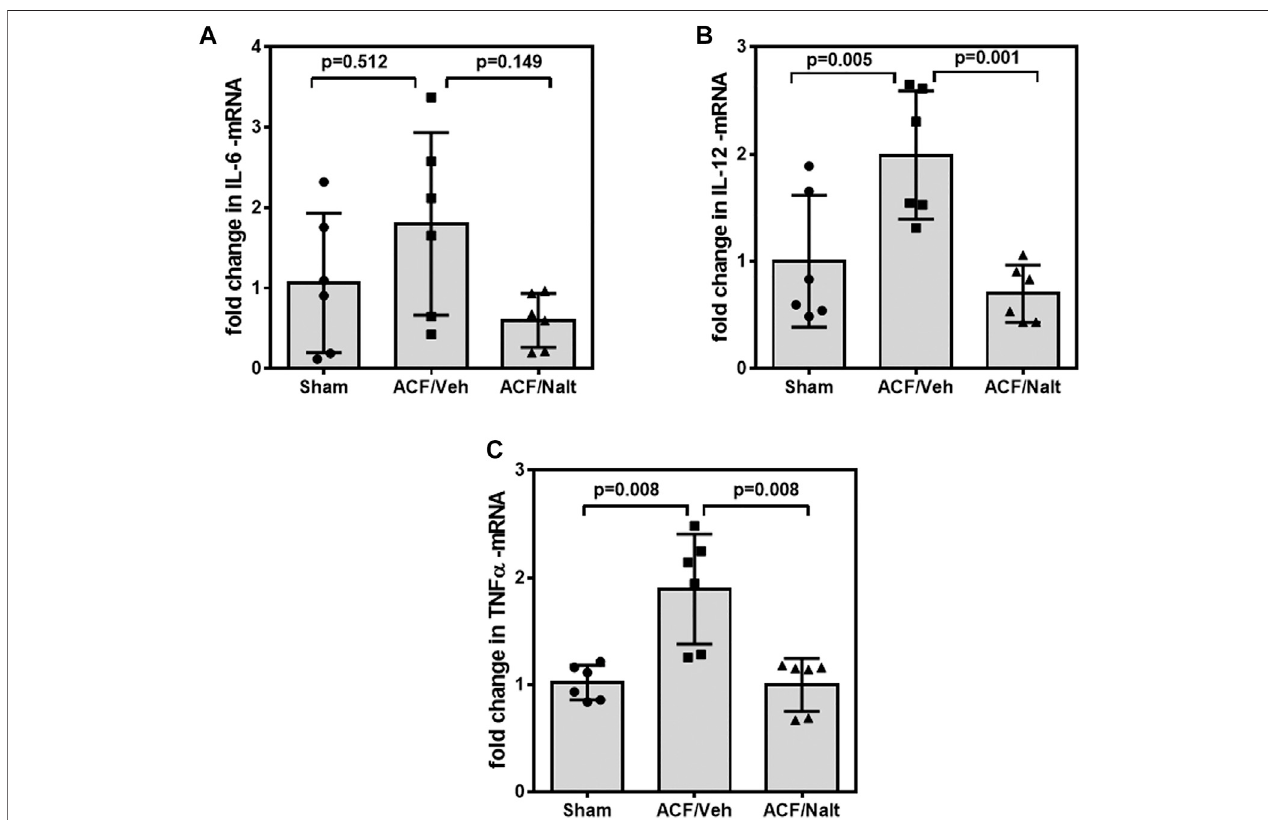
FIGURE6| QuantitativeRT-PCRInterleukin6(IL-6) (A) ,Interleukin12(IL-12) (B) andtumornecrosisfactor α (TNF-alpha) (C) speci fi cmRNAvaluesofcontrol,ACF/ Vehicle- and ACF/Naltrexone-treated rats. Values of in fl ammatory cytokines were signi fi cantly increased in ACF/Vehicle treated rats compared to controls (IL-12: p = 0.005; TNF-alpha: p = 0.008) but not for IL-6 ( p = 0.512). Chronic naltrexone treatment in ACF rats was concomitant with a signi fi cant decrease in the in fl ammatory cytokine mRNA (IL-12: p = 0.001; TNF-alpha: p = 0.008) but not for IL-6 ( p = 0.149). Data represent medians (range) ( n = 6